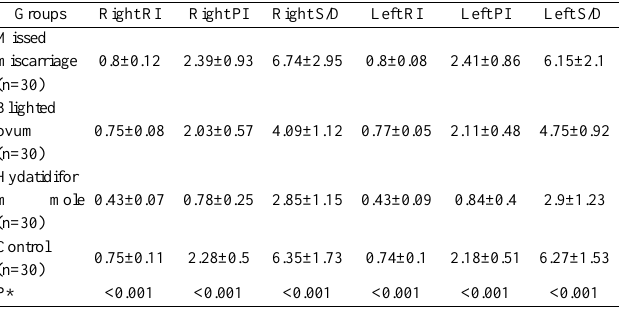
Table 2: Uterine artery Doppler parameters means between study groups.